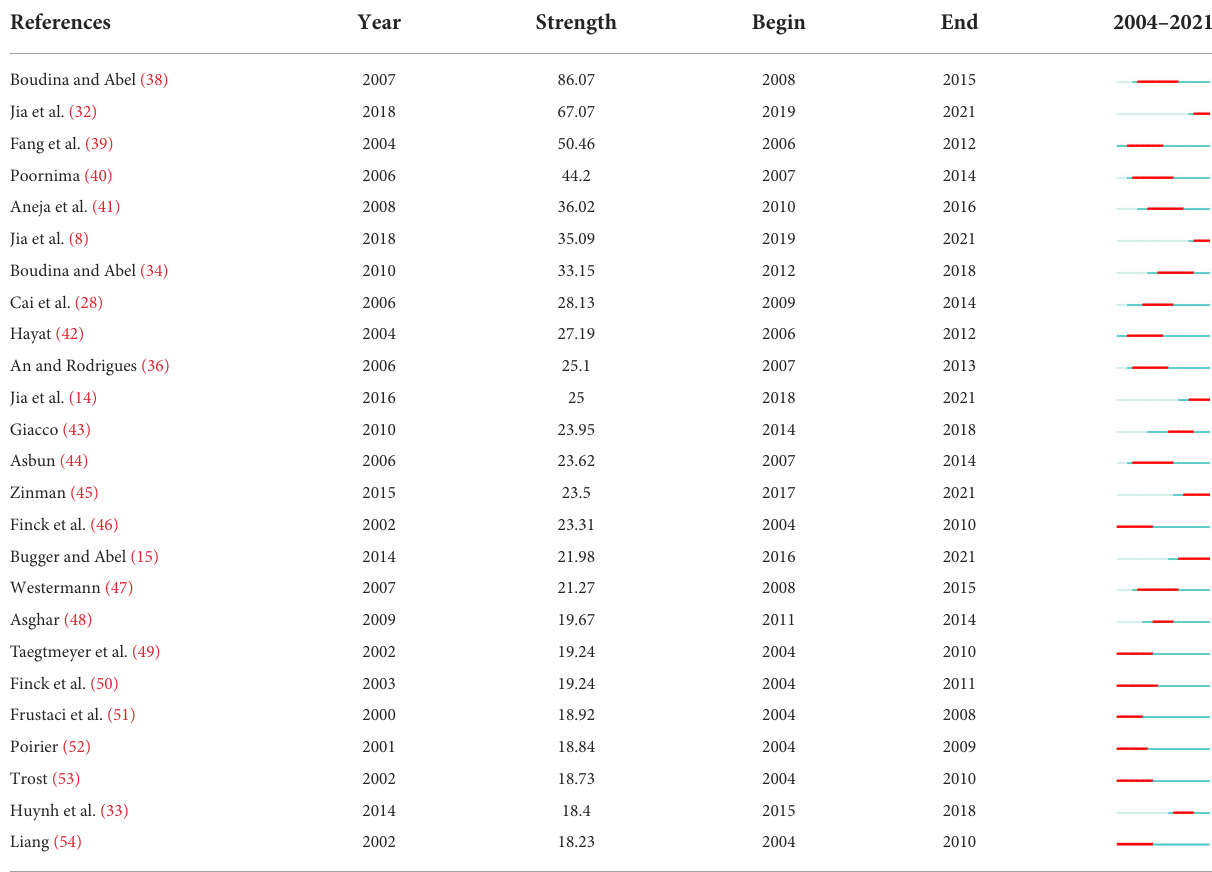
TABLE 4 The top 25 references with the strongest citation